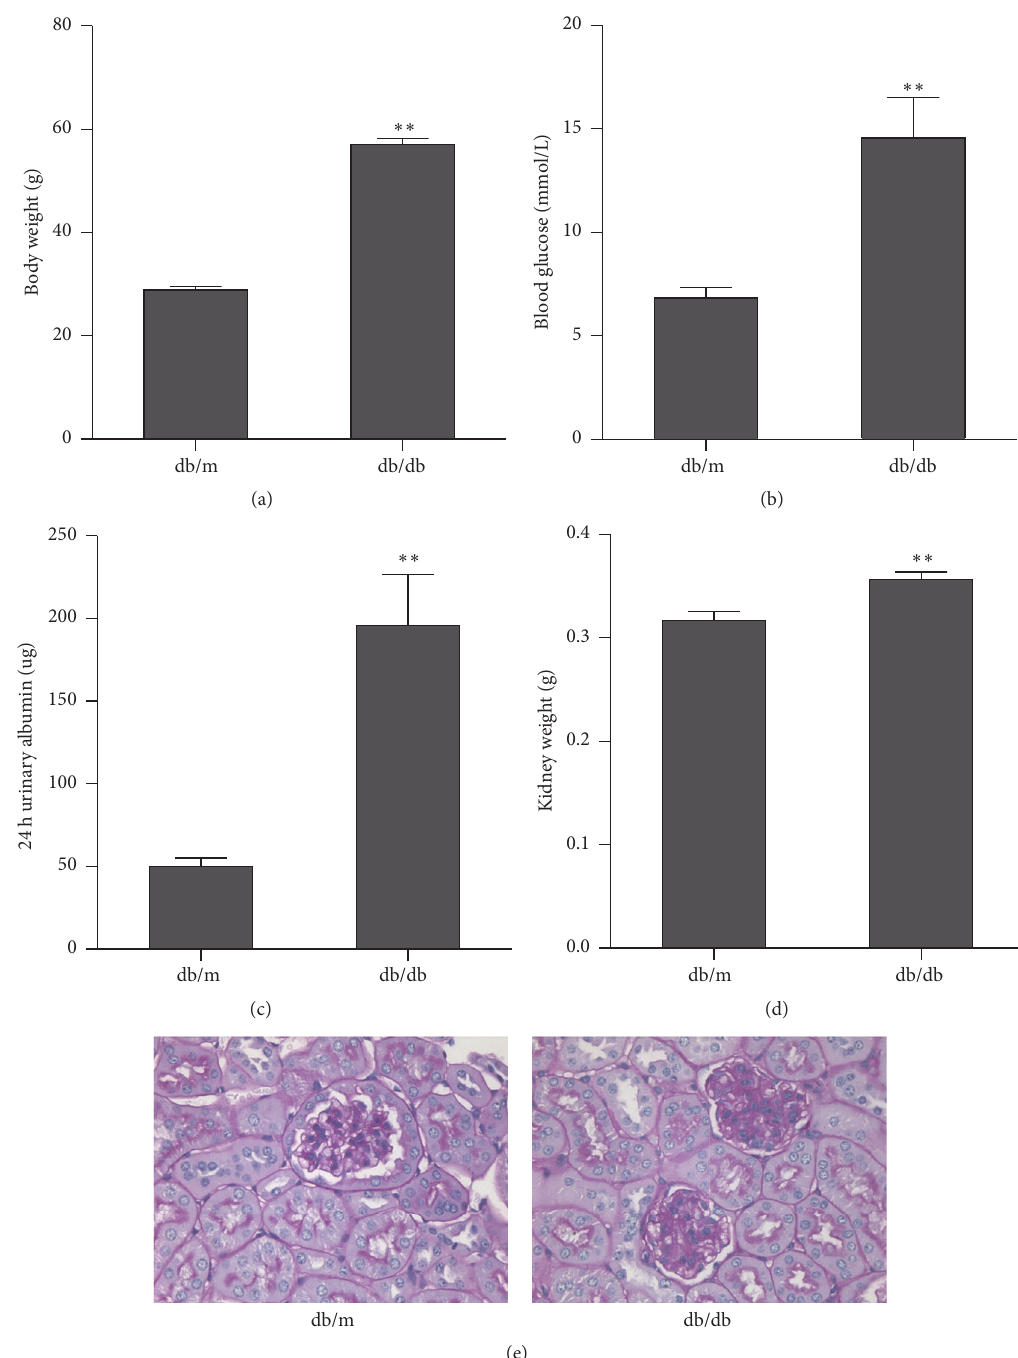
Figure 1: Comparison between db/db mice and db/m mice in terms of body weight (a), blood glucose (b), 24 h urinary albumin (c), and kidney weight (d). Renal histological changes are denoted by (e). Data presented as mean + SEM ∗∗ 𝑝 < 0.01 , db/db versus